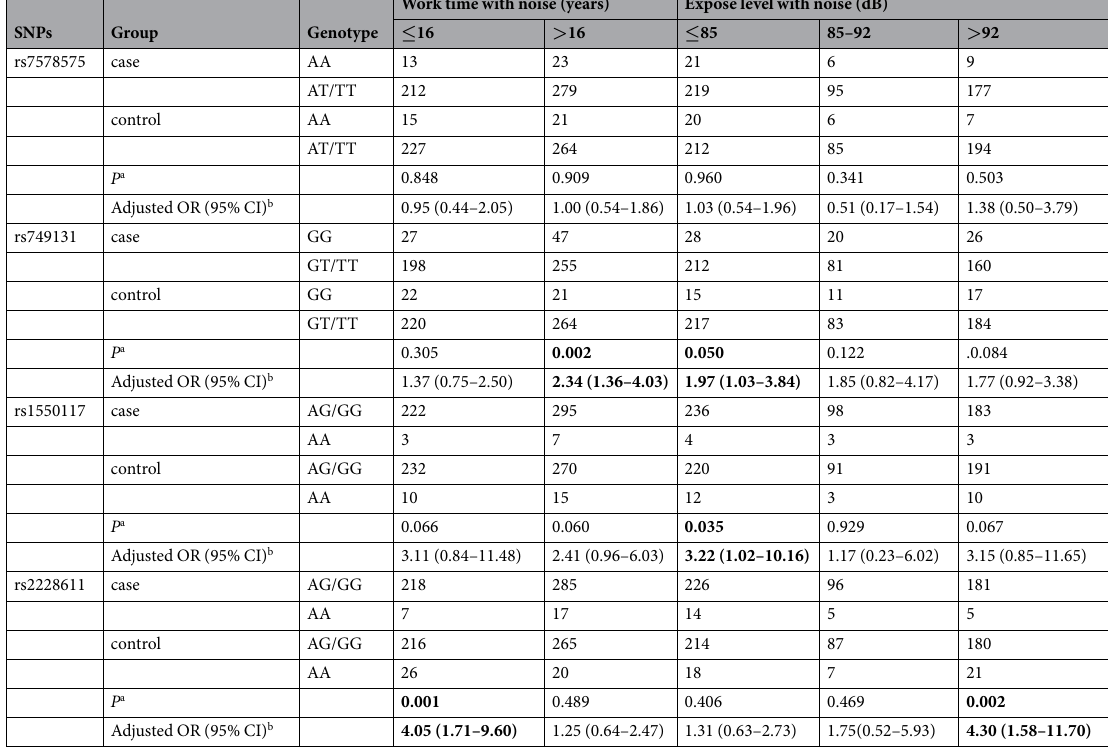
Table 4. Stratified analysis of SNPs in a recessive model. a Two-sided χ 2 test. b Adjusted for age, sex, smoking, drinking in logistic regression